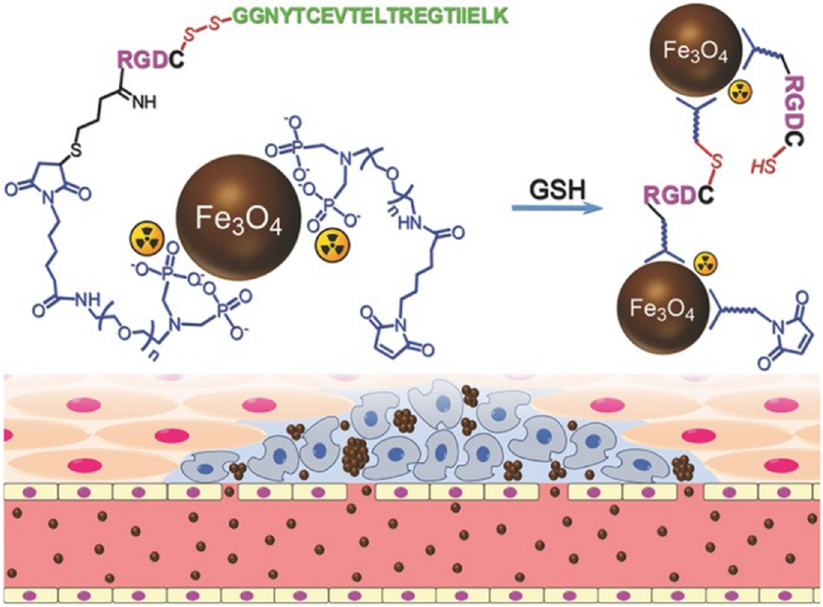
Figure 3. The design of 99m Tc-labeled anti-phagocytosis Fe 3 O 4 nanoparticles and the cross-linking reaction between the particles to trigger the formation of particle aggregation in the tumor micro-environment by GSH [71] . Reproduced with permission from Wiley-VCH GmbH, Weinheim 2017.